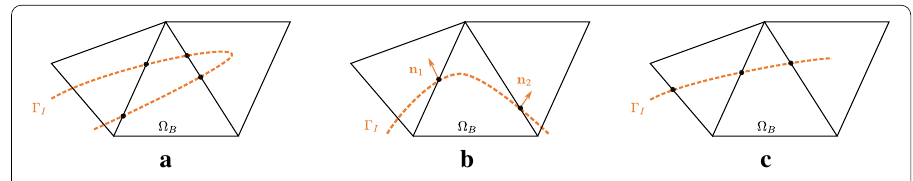
Fig. 23 Problematic cases to be tagged for refinement. a Double-intersected edges. b High change in curvature. c Elements with no cutting